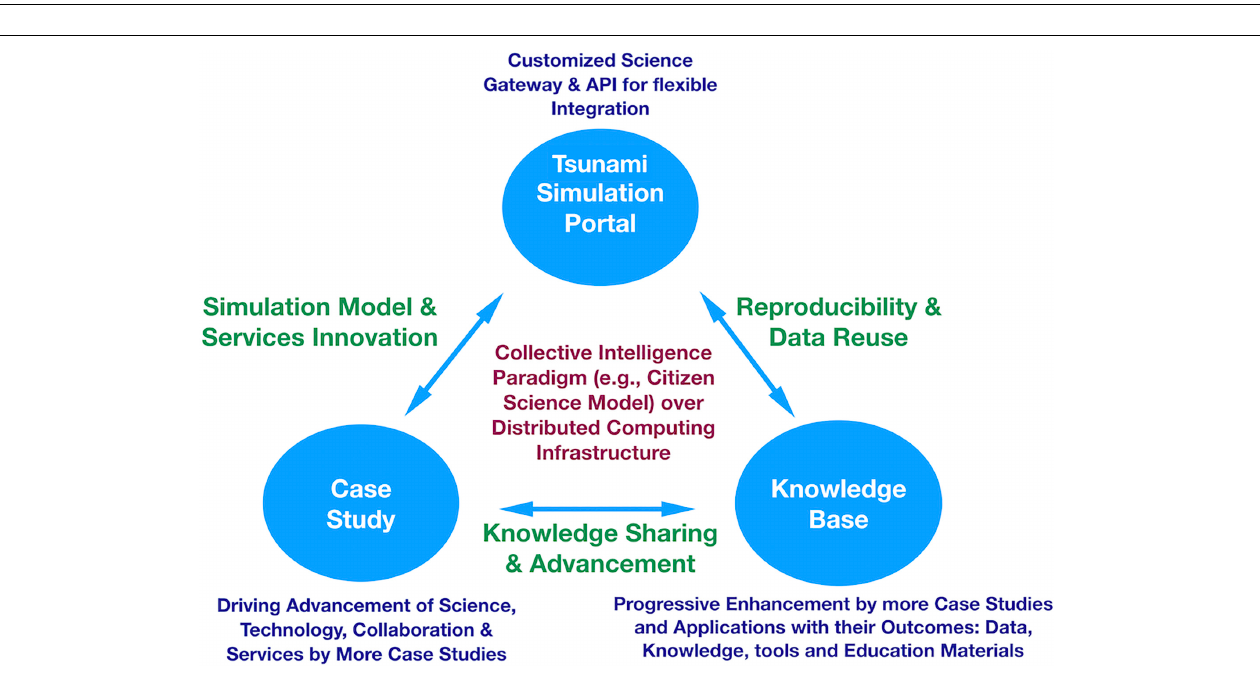
FIGURE 7 | (Left panel) The computed maximum free surface elevation. The color shading indicates the maximum free surface elevation in meter. This plot has been zoomed in from the original computational domain to the regions of Palu Bay. The solid red diamond indicates the location of Pantoloan. (Right panel) The comparison between the simulated tsunami and the observed tsunami at Pantoloan. The blue line indicates the numerical results of COMCOT, and the black line indicates the observed tsunami. Note that the observed tsunami has been filtered by the high-pass filter with the 6-h cutoff frequency. The y -axis indicates the time after the mainshock of the earthquake (10:02 UTC, September 28, 2018).